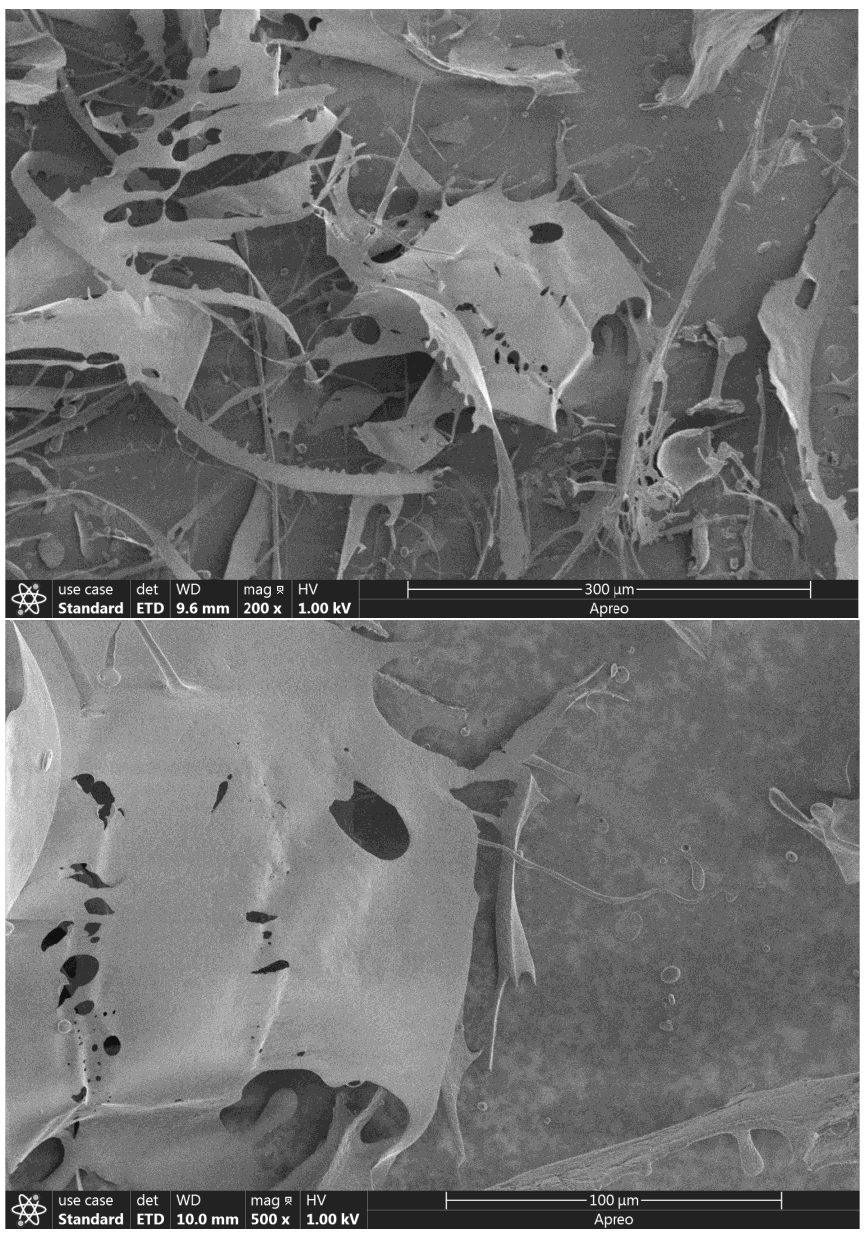
Figure 4. SEM photographs of ZSP(200× and 500×). EDX spectra is often used to verify the combination of metal ions and biomass [16]. EDX spectra indicated the main elements for ZSP are C, O and N (Figure 5). After three metal ions adsorption, new peaks emerged, indicating successful binding of Pb 2+ , Cu 2+ , Cd 2+ with ZSP.